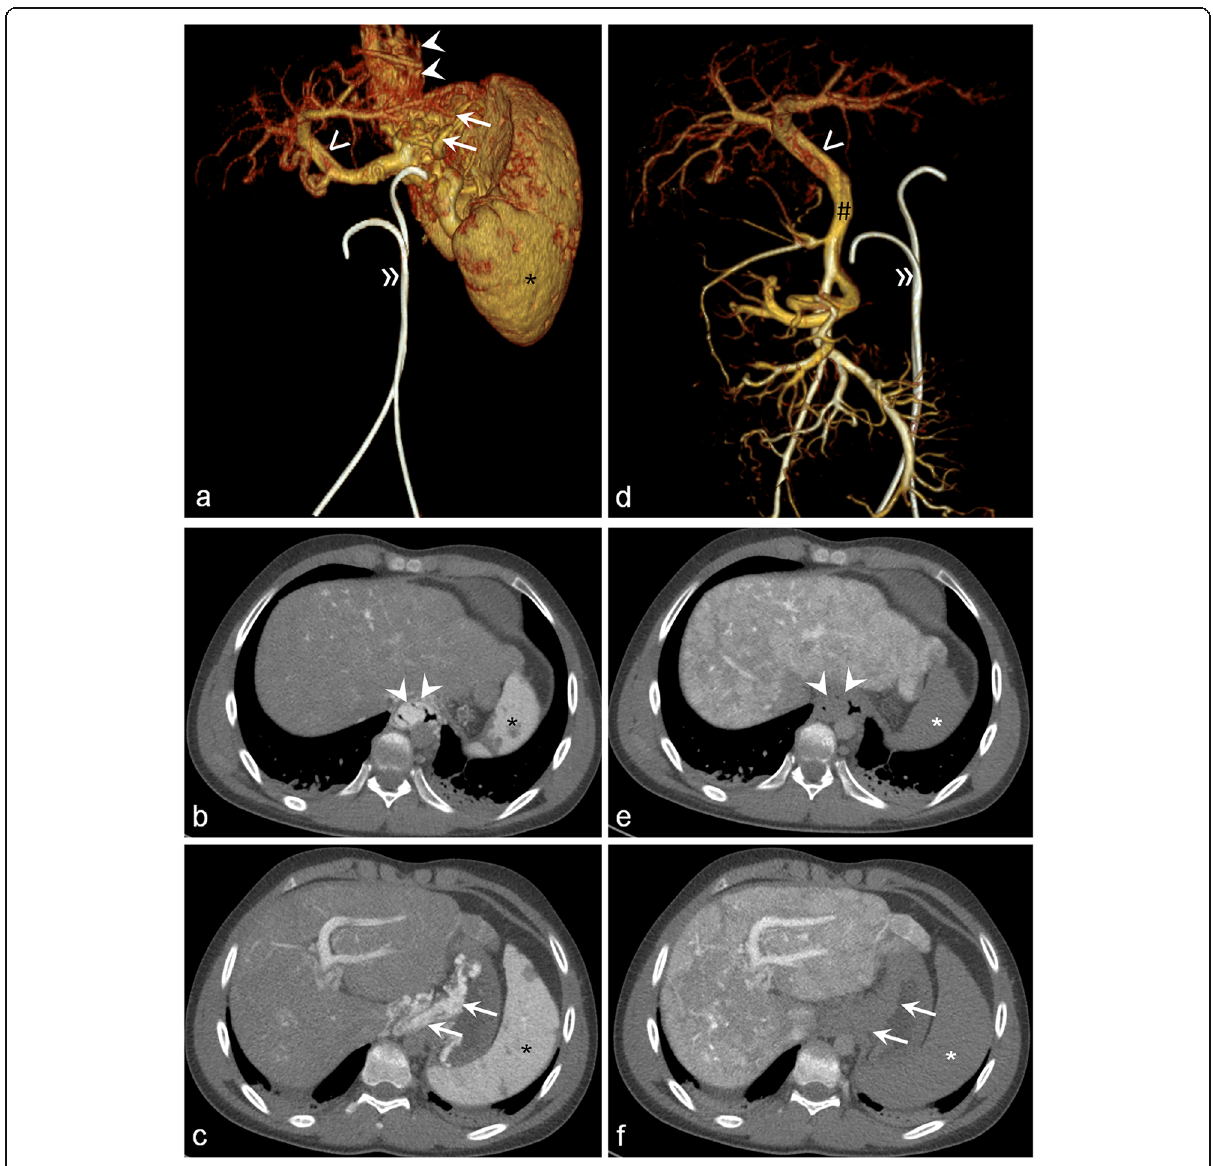
Fig. 2 A 16-year-old male patient with portal hypertension. a – c Volume rendering and axial images of computed tomography arteriosplenography after contrast injection into the splenic artery allow to detect filling of oesophageal ( b , arrowheads) and gastric ( c , arrows) varices. Note the contrast enhancement of the spleen (black asterisk). d – f Volume rendering and axial images of computed tomography arterioportography after contrast injection into the superior mesenteric artery detect filling of the superior mesenteric vein (hashtag) and